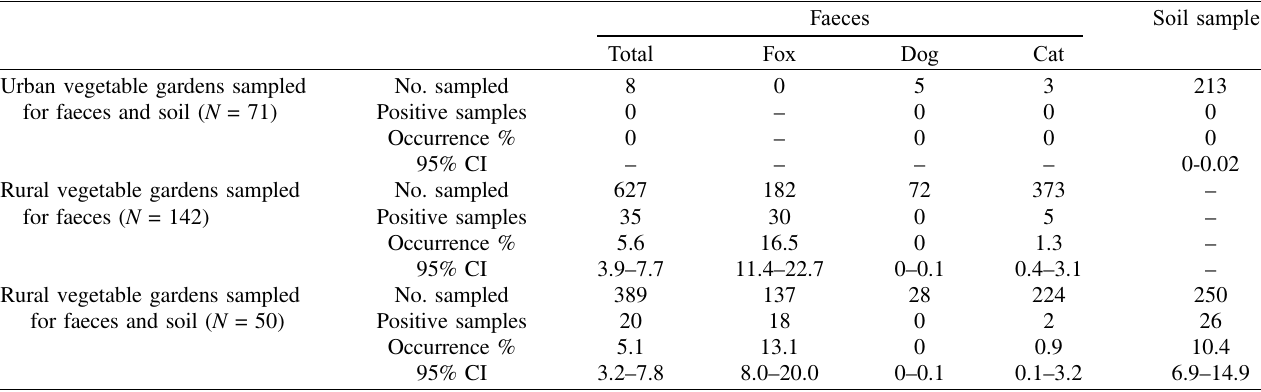
Table 1. Number of fox, dog and cat faeces found in rural and urban vegetable gardens in north-eastern France and number of faeces and soil samples testing positive for E. multilocularis by real-time PCR. Faeces Soil samples Total Fox Dog